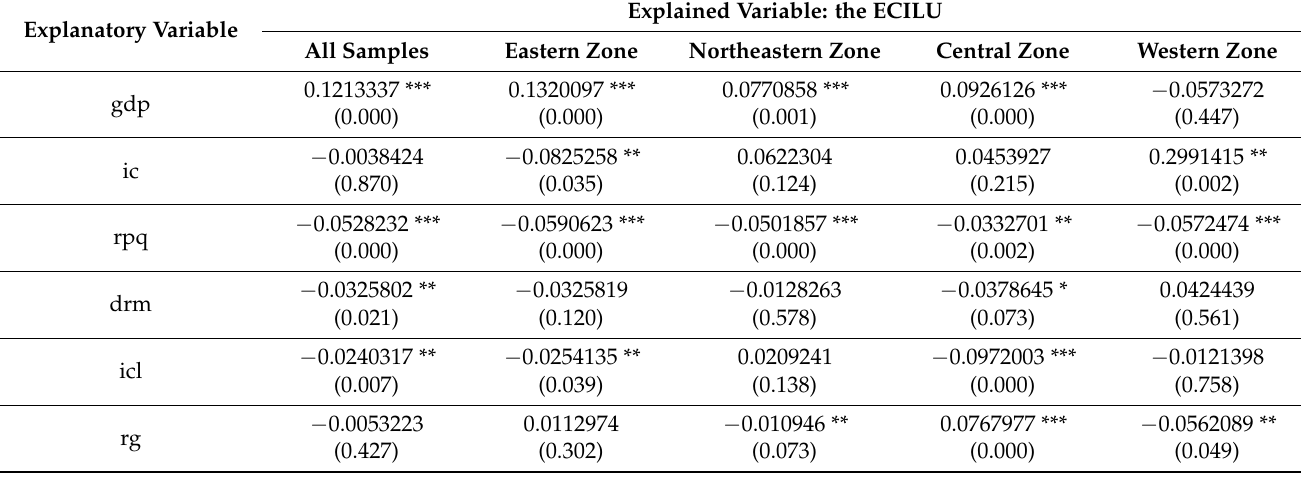
Table 6. Tobit regression analysis results of the